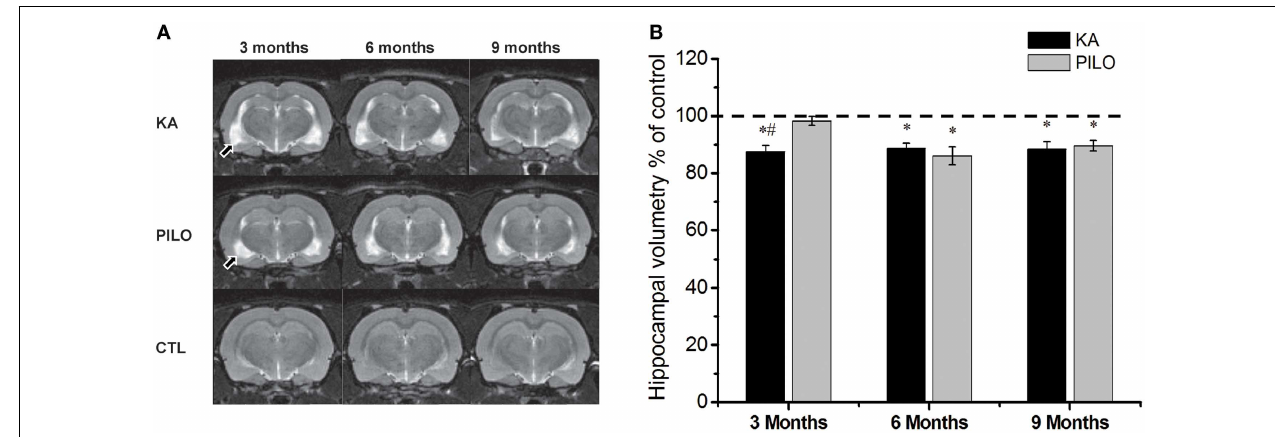
post SE, the KA group shows a significant reduction in hippocampal volumetric as compared to the PILO ( # P < 0.01) and control groups (* P < 0.05). Both models, however, had a similar profile at 6 and 9months post SE. Data is expressed as a percentage of control. Arrows in (A) indicate ventricular changes in the KA and PILO groups compared to controls.